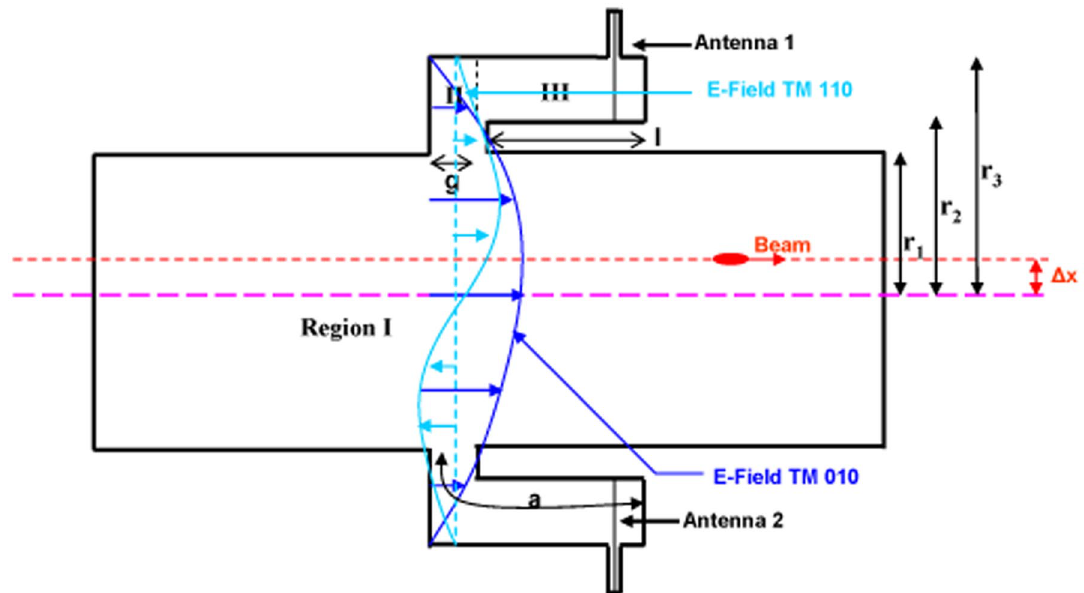
FIG. 1. (Color) Geometry of the reentrant cavity